Question: According to this chart, does the measure grow or shrink?
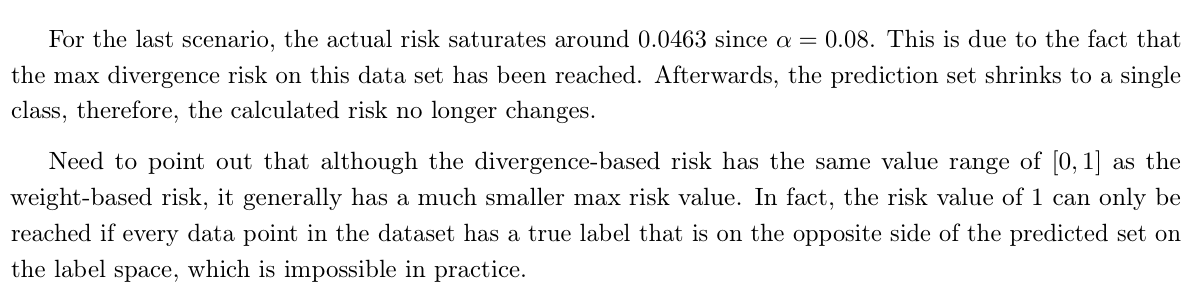
Answer: increasing